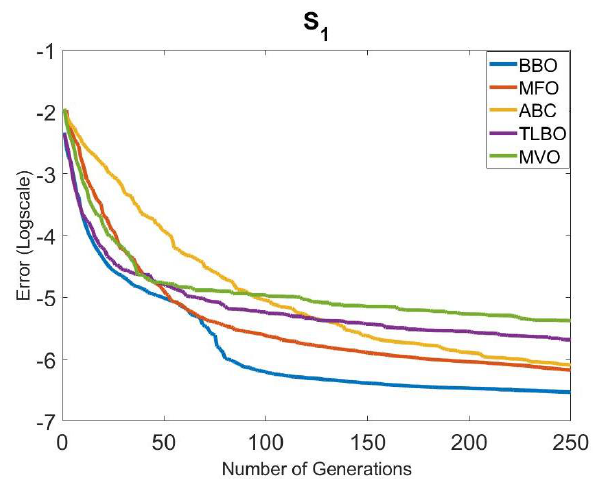
Figure 4. Comparison of the convergence of the metaheuristic algorithms in Group 1 for S 1 .